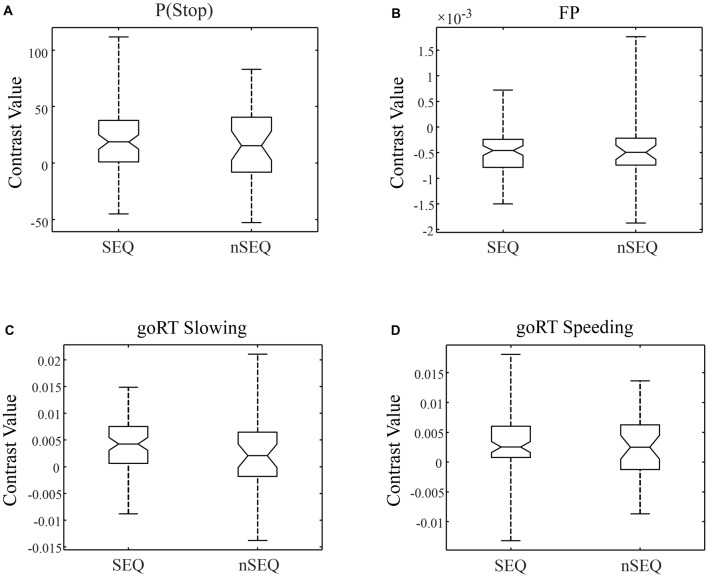
Box plots of beta weights, SEQ vs. nSEQ. (A) Stop signal anticipation: P(Stop); (B) motor preparation: FP; (C) go trial RT slowing; (D) go trial RT speeding. SEQ and nSEQ were indistinguishable for all contrasts (p’s > 0.05).